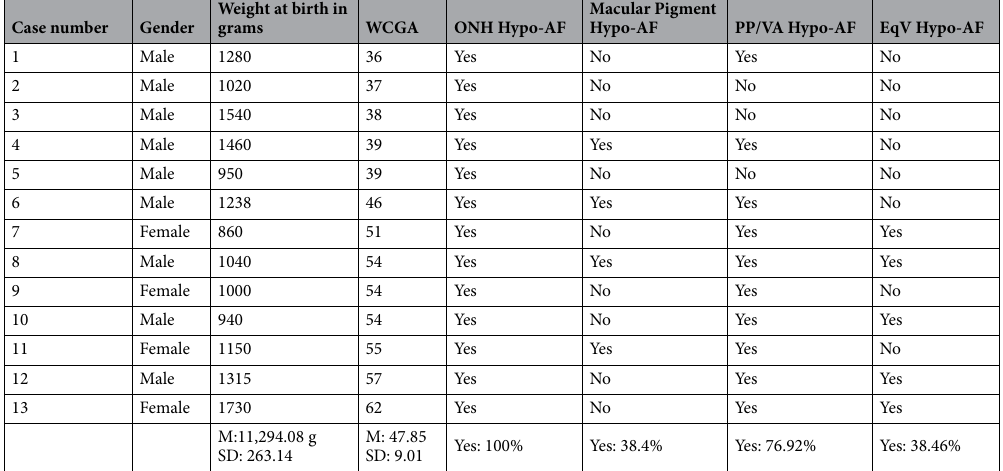
Table 1. Identification of hypo-AF structures. Hypo-AF hypo-autofluorescence, WCGA weeks of corrected gestational age, ONH optic nerve head, PP/VA peripapillary/vascular arcades, EqV equatorial vessels, M mean, SD standard